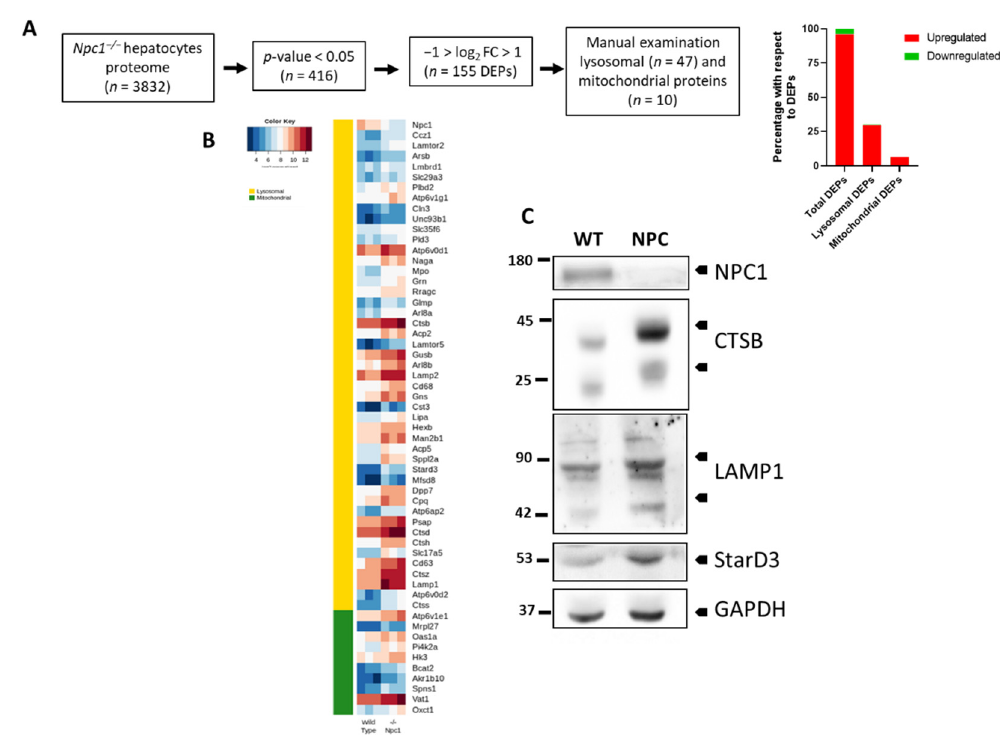
Figure 3. Lysosomal and mitochondrial proteins differentially expressed in hepatocytes from wild type and Npc1 − / − mice. ( A ) Summary of the computational pipeline for proteome analysis and bar chart representation of the total, mitochondrial and lysosomal proteins that present changes in Npc1 − / − hepatocytes. ( B ) Heat map presenting differentially expressed lysosomal and mitochondrial proteins in wild type and Npc1 − / − hepatocytes ( n = 3). ( C ) Western blot analysis of liver homogenates confirmed the decreased expression of NPC1 and increased expression of CTSB, LAMP1, and StarD3 proteins in 6 weeks old Npc1 − / − mice (NPC) compared to wild type (WT) mice of the same age.